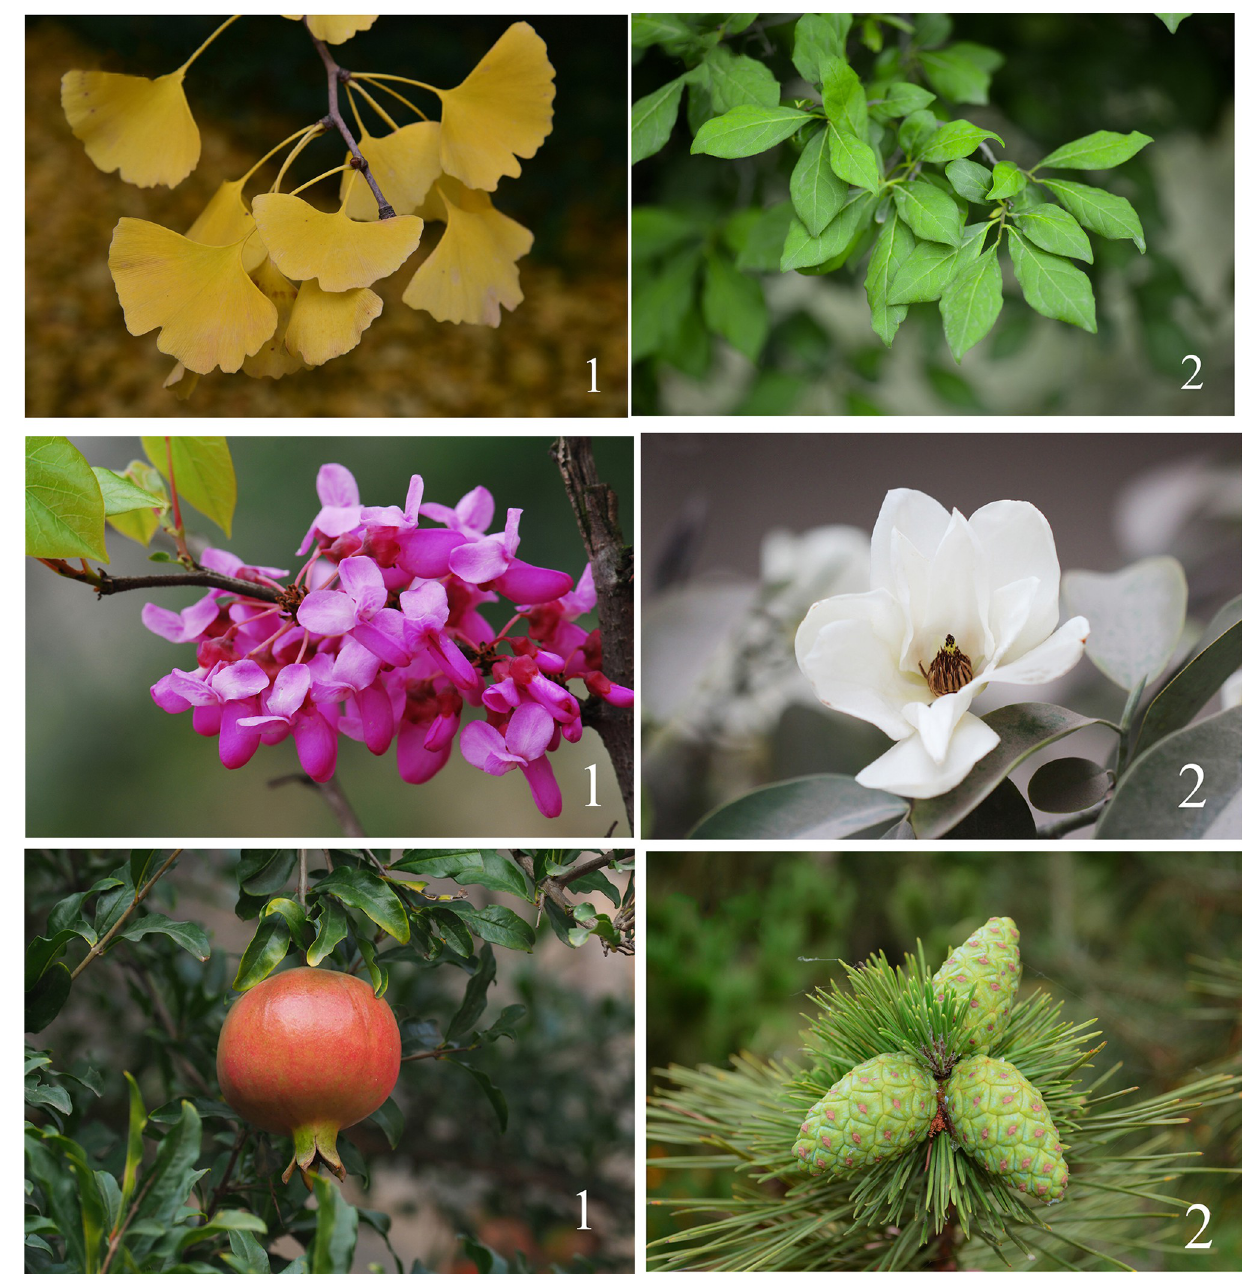
Fig 1. Pictures of some plant organs used in experiments. (a) leaves. 1 is the leaves of Ginkgo biloba , which is sector, yellow and leathery; 2 is the leaves of Diospyros rhombifolia , which is oval, green and paper-like. (b) Flowers. 1 is the flower of Cercis chinensis , with is raceme and purple; 2 is the flower of Michelia maudiae , which is solitary and white. (c) Fruits. 1 is the fruit of Punica granatum , which is spherical, berry, red and large; 2 is the fruit of Pinus thunbergii , which is oval, cone, green and